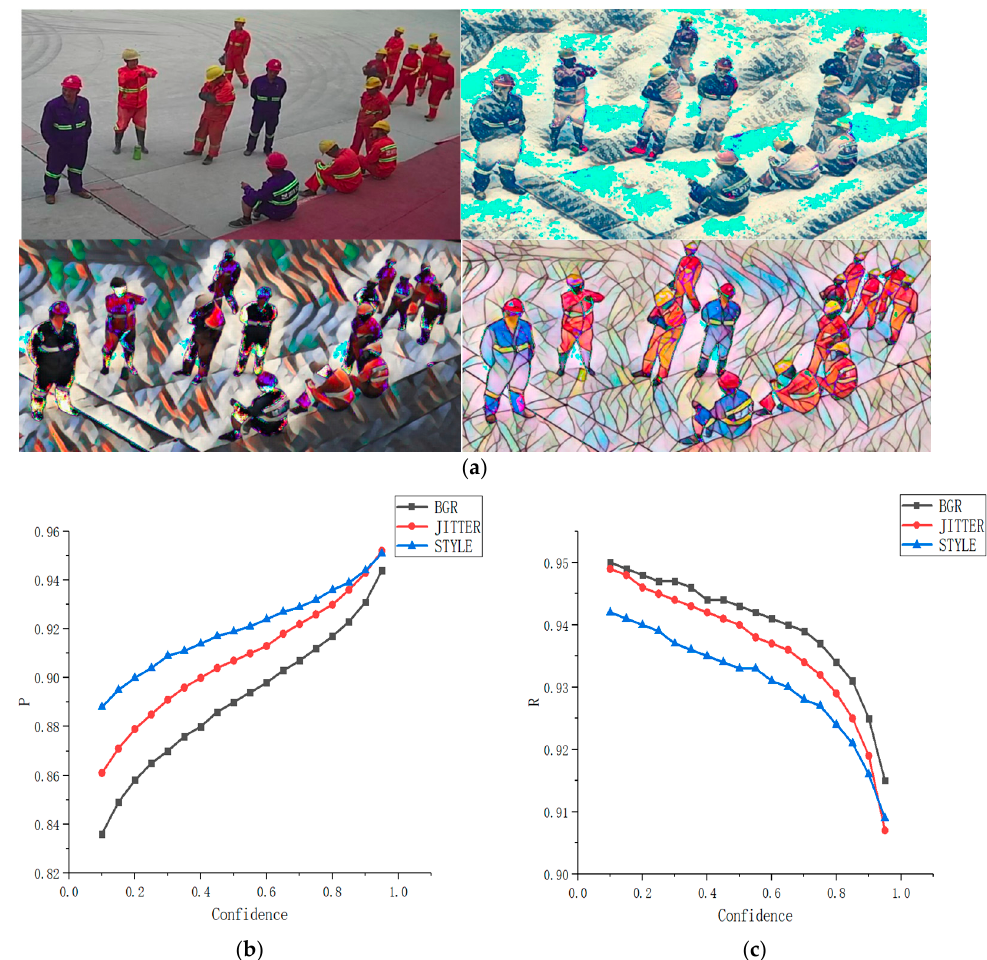
Figure 5. ( a ) The effect of performing augmentation transformation on datasets; ( b ) detection accuracy curves of the three schemes; ( c ) recall curves of the three schemes.